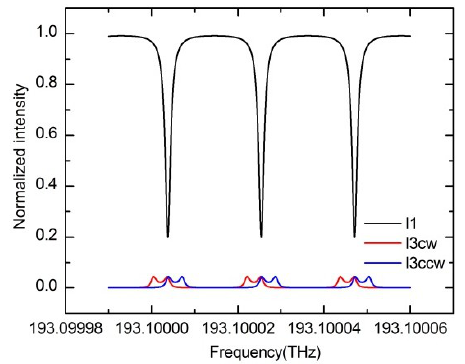
Figure 12. Calculated resonance curves when the Rayleigh scattering coefficient and the recapture factor are 0.001. The red solid line is the simulation result of the I 3 when the gyroscope rotates CW. The blue solid line is the simulation result of the I 3 when the gyroscope rotates CCW.